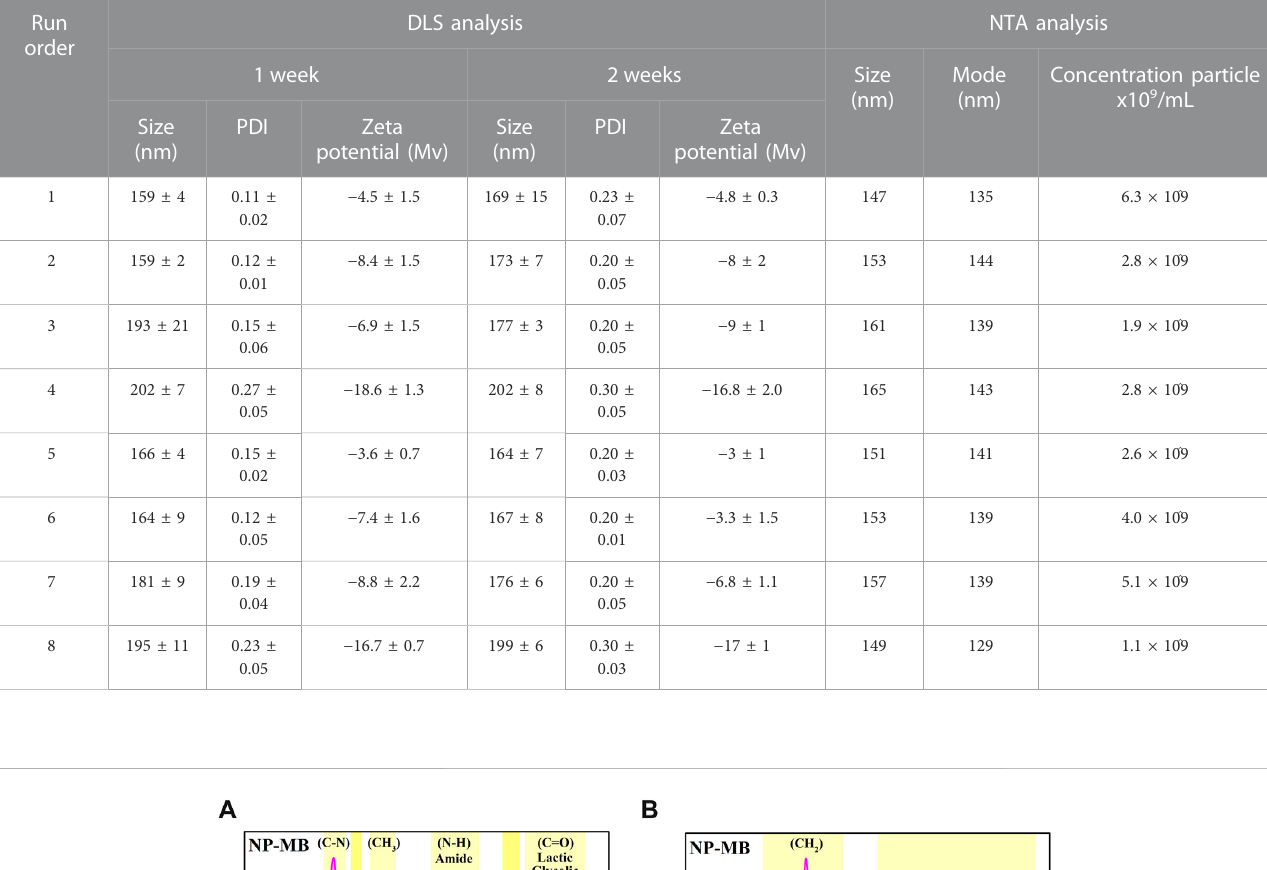
TABLE 4 DLS parameters of short-time stability of membrane cell-derived coating nanostructures and NTA acquired data. DLS data are expressed as a mean of 3 different measures and standard deviation.